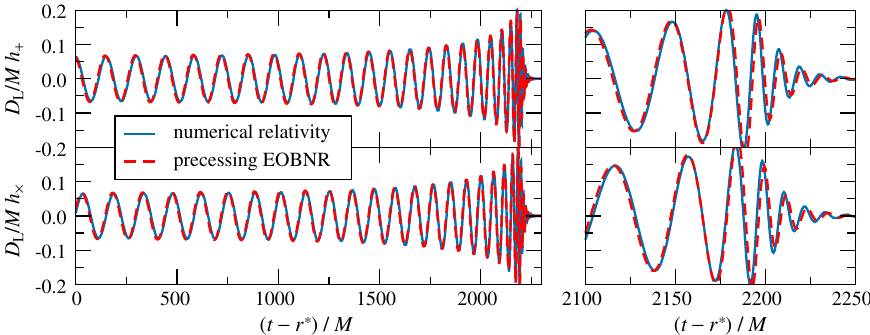
FIG. 7. A visual comparison of the precessing EOBNR model with NR GW polarizations computed by the SXS Collaboration at (approximately) the GW150914 MaP parameters. The intrinsic parameters of the NR waveform are q ¼ 0 . 81 , a 1 ¼ 0 . 34 , a 2 ¼ 0 . 67 . The inclination is ι ¼ 2 . 856 rad. The alignment of the precessing EOBNR waveform is obtained from the sky- and polarization- averaged overlap with the NR waveform. For more details on the alignment procedure, see Ref.